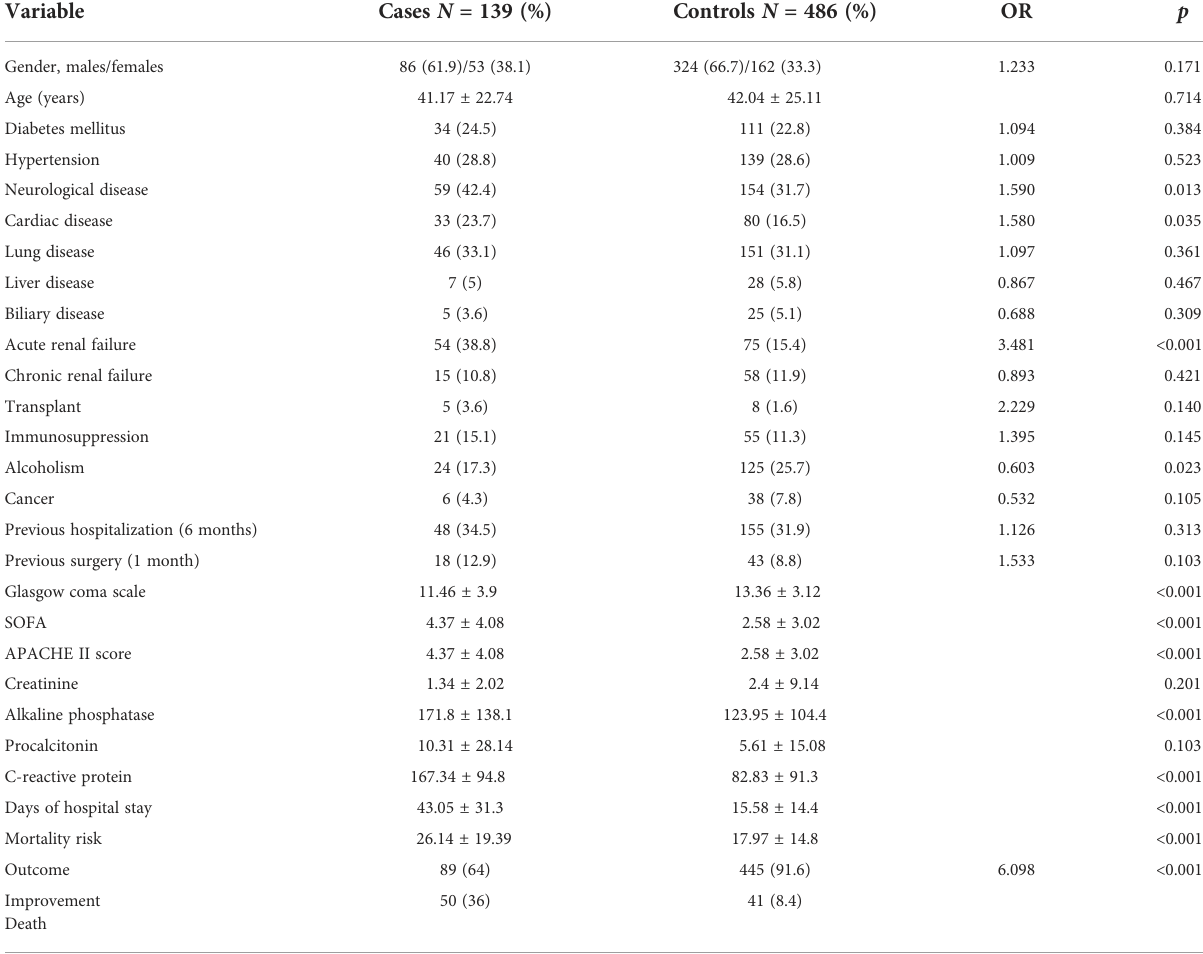
TABLE 1 Characteristics of cases of patients infected with Klebsiella pneumoniae NDM-1 and controls. Variable